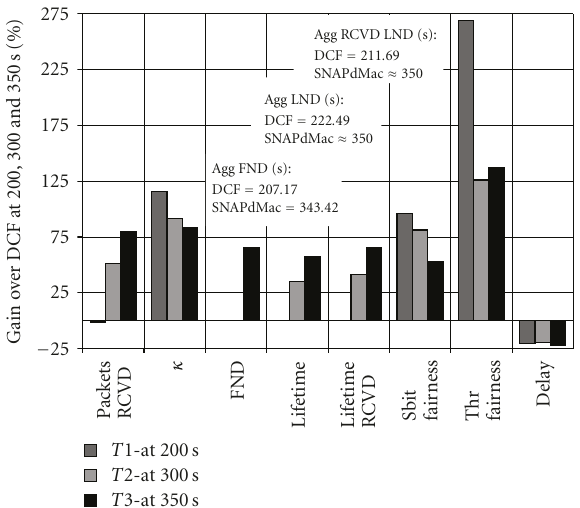
Figure 10: General results of HD/C scenario (1)—homogeneous network.